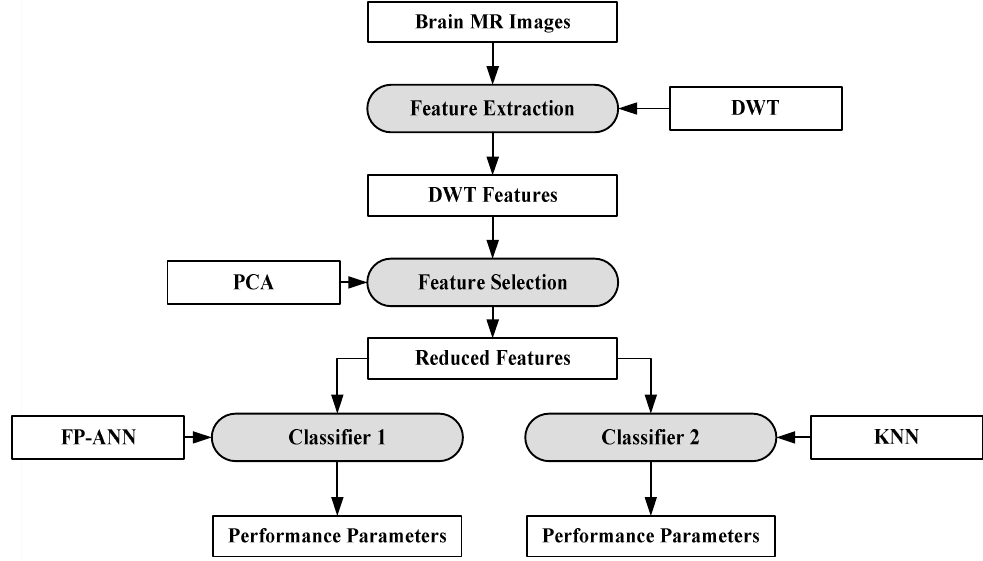
Figure 6. Hybrid characterization system for brain cancer characterization [88].